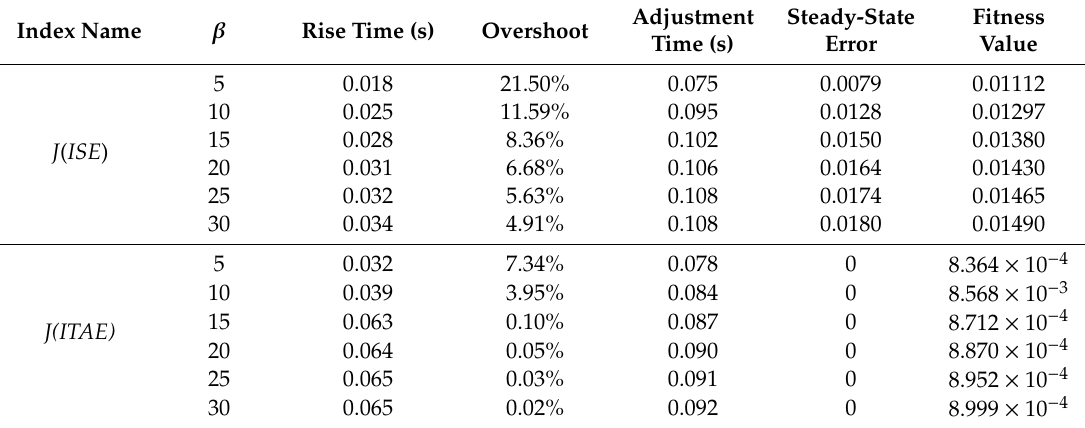
Table 2. Di ff erent results of optimization with the di ff erent β